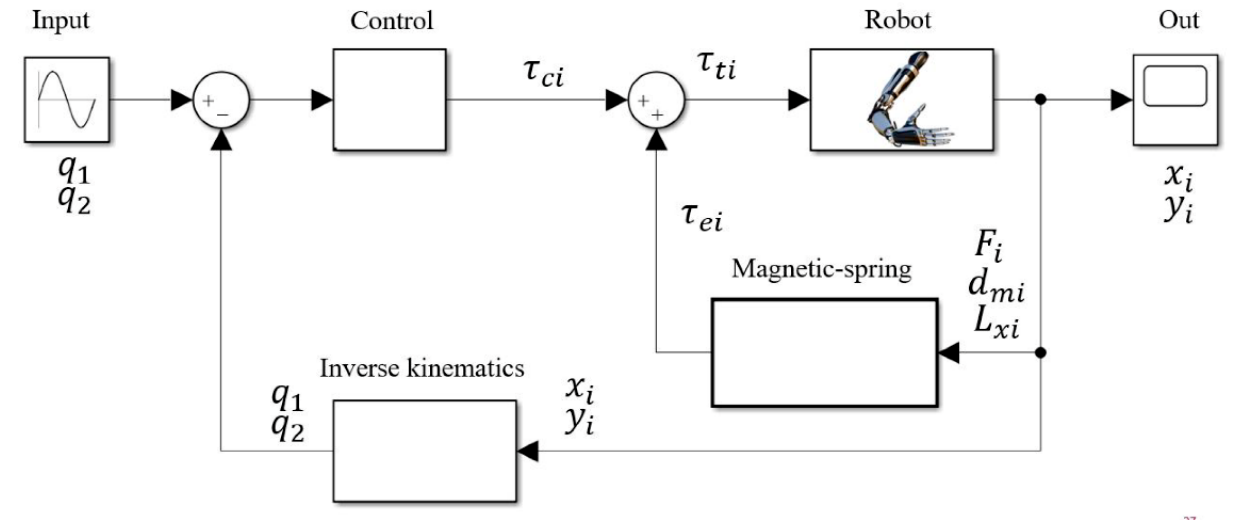
Figure 6. Control diagram, including the magnetic spring system.